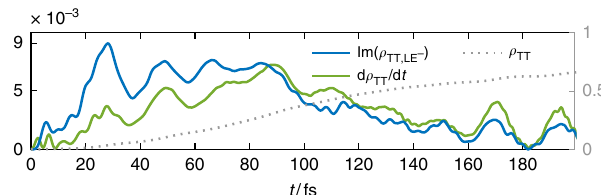
Fig. 5 Evidence for coherent transport. The change d ρ TT /d t of ρ TT correlates with the dynamic coherence Im( ρ TT , LE − ) indicating coherent superexchange via B 1 . The large oscillations with period of 20 fs correlate with A 1,2 oscillations (see Fig. 4b). The maximum SF rate is achieved at 90 fs during the passage of the avoided crossing in the TES shown in